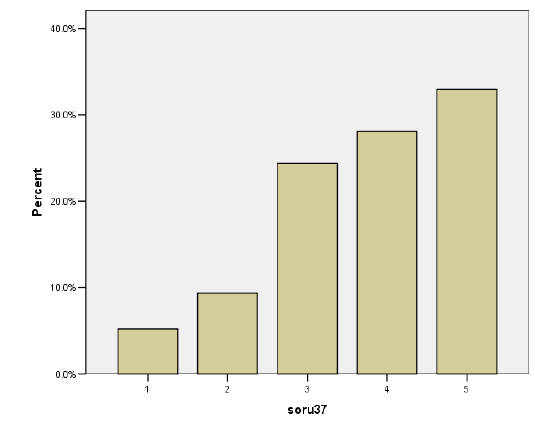
Figure 16. Should group study and teamwork be implemented extensively for accounting courses? Q35: Should case studies and role playing be implemented extensively for accounting courses?